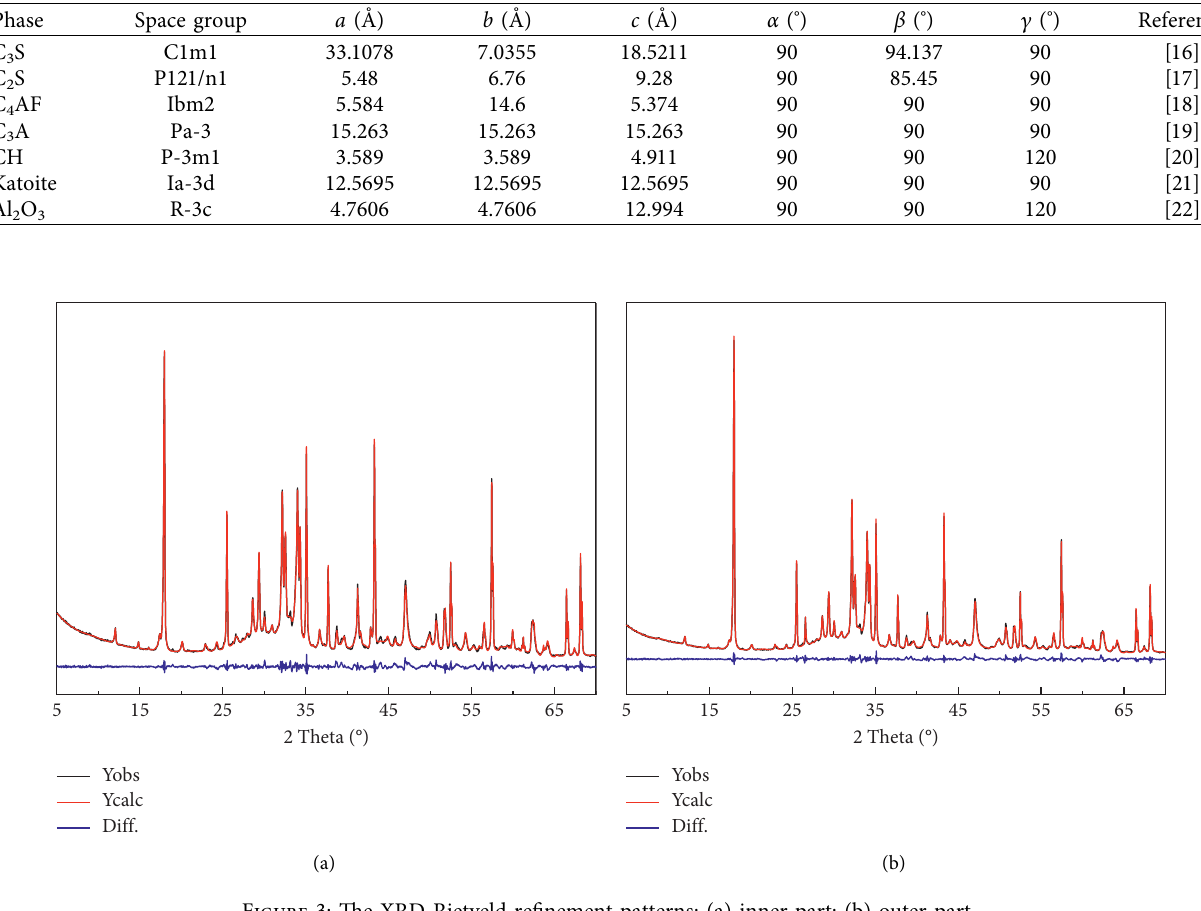
Table 4: The crystal structure of phases used in Rietveld refinement.